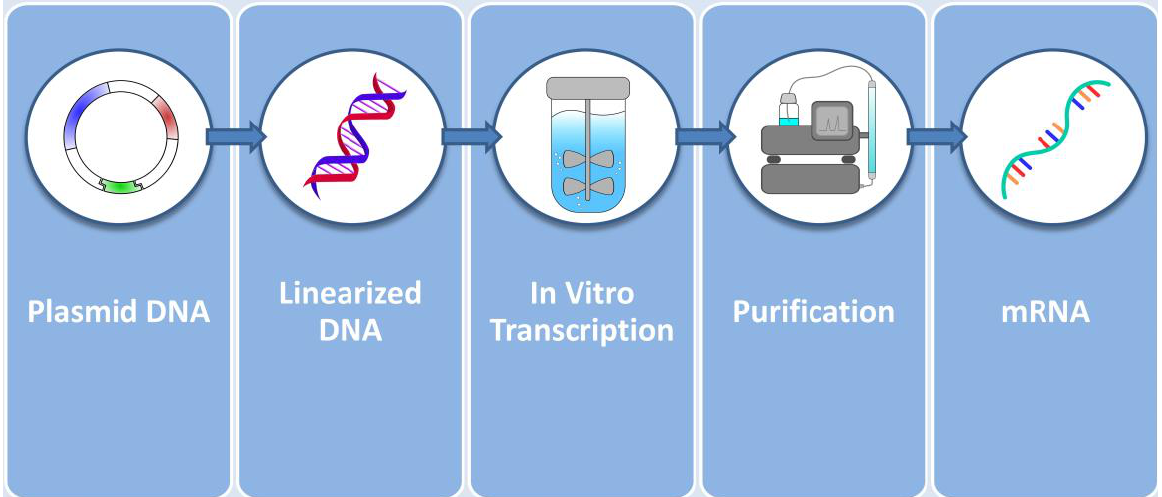
Figure 3. In vitro production of mRNA from plasmids. Plasmids coding for the intron-depleted optimized mRNA sequence are first linearized and then added to the bioreactor alongside with RNA polymerase, dNTPs, a buffer system and supplementary reagents. The resulting product is then purified by chromatography and flow filtration techniques and is ready to be encapsulated into delivery vectors.